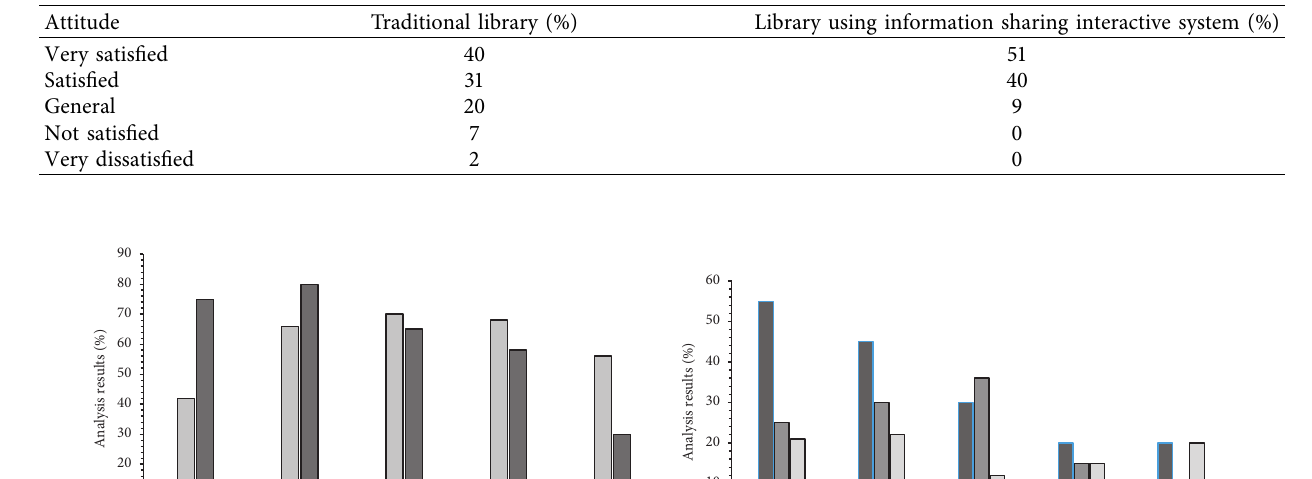
Table 4: Survey results on the implementation of personalized customized services.